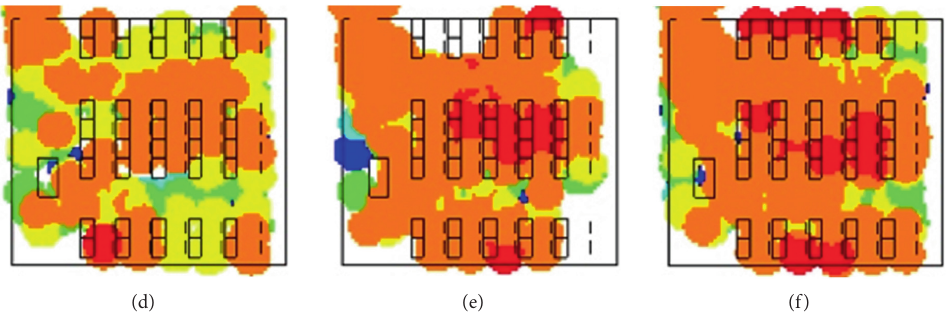
Figure 10: Flow size-based cumulative maximum density under orderly distribution conditions. The space utilization illustrates the space using of pedestrians in an emergency. The more the routes are chosen, the higher the space utilization is, and the deeper the color is. The blue color denotes the less choice, and the red color denotes the more choice. (a) 10. (b) 15. (c) 20 (d) 25. (e) 30. (f) 35.